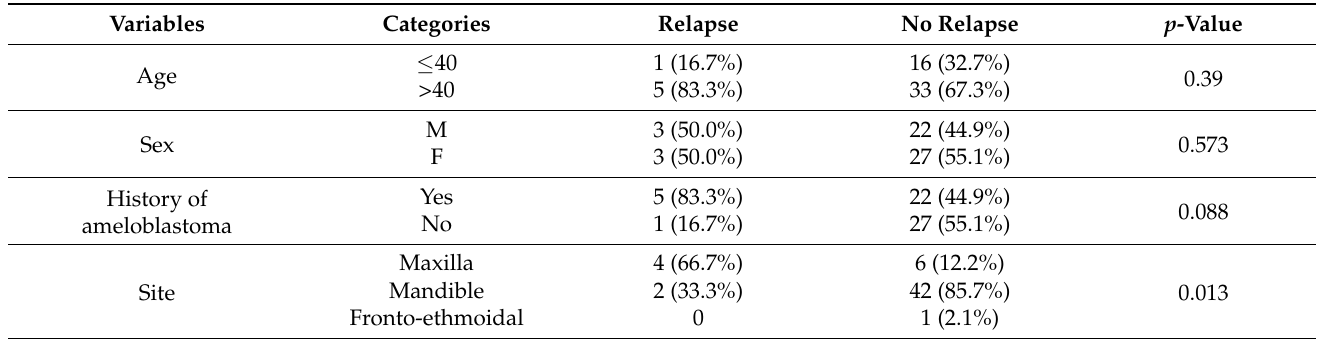
Table 5. The main differences between patients who developed relapses and patients who remained